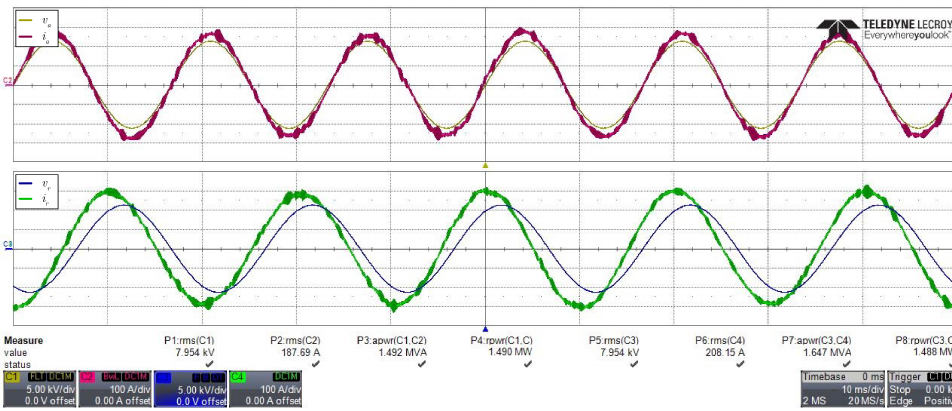
Figure 14. Converter operation with 5 MVA apparent power in port 2 with cos( φ ) = 0.9, and port 1 with 4.5 MW and the unit power